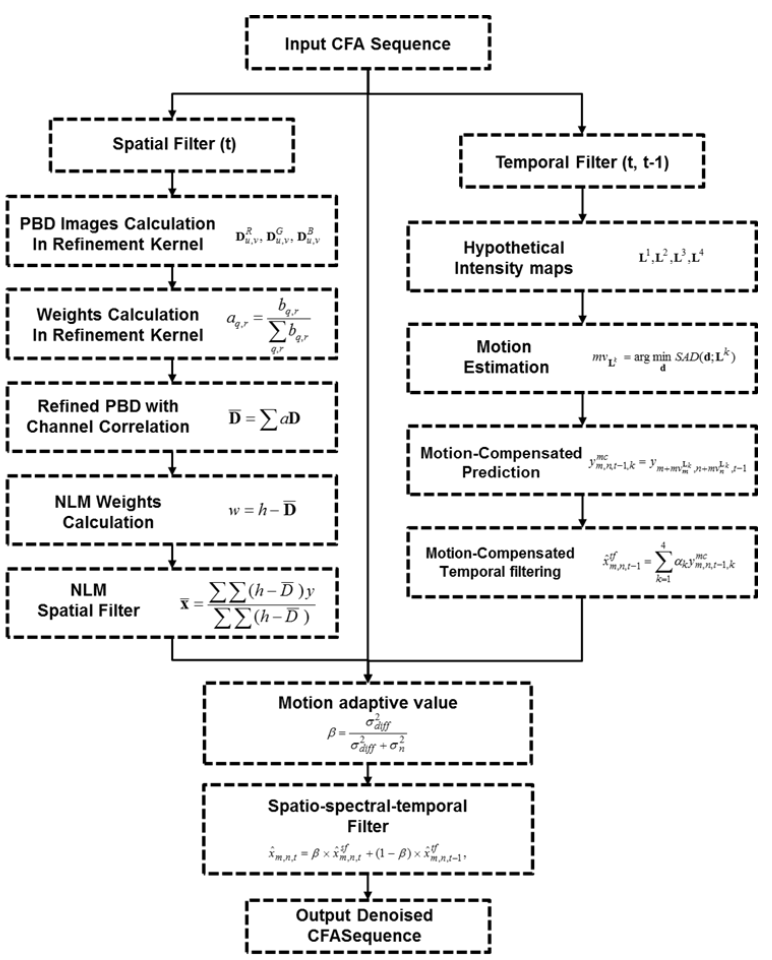
Figure 8. Overall flowchart of the proposed method.